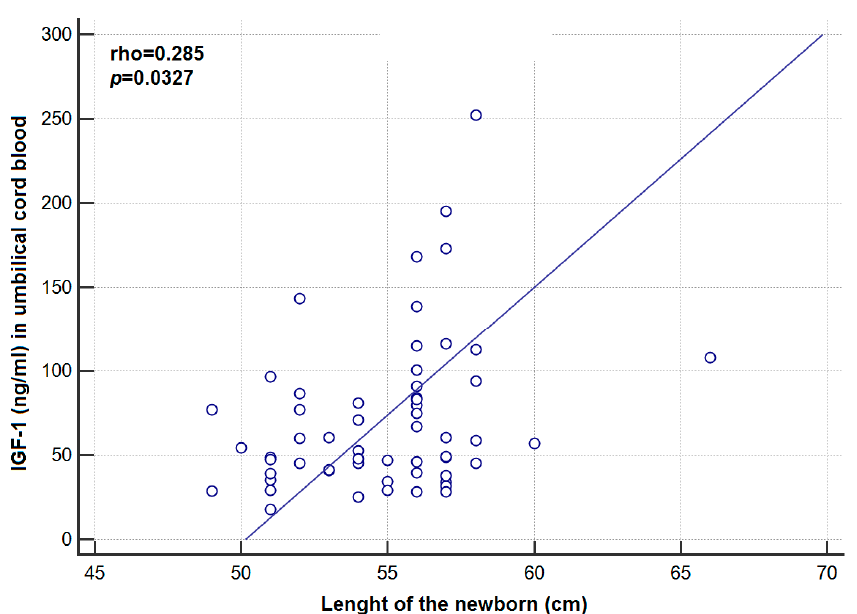
Figure 1. Correlation between concentration of IGF ‐ 1 in umbilical cord blood and the length of the newborn in the GDM group. Table 3. Spearman’s correlation between maternal plasma (IGF ‐ 1, IGF ‐ 2, IGFBP ‐ 1, IGFBP ‐ 2, IGFBP ‐ 3) concentrations (ng/mL) and clinical/biochemical parameters in the GDM group.